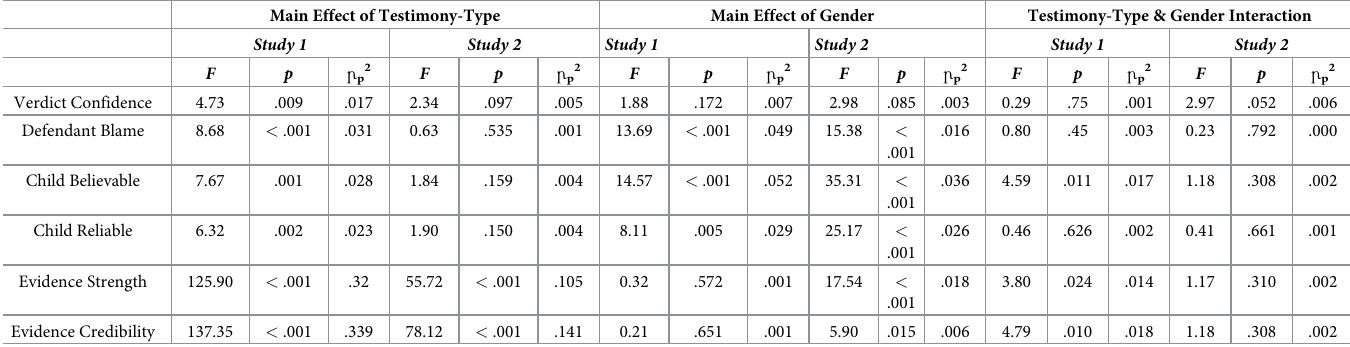
Table 2. ANOVA results for all main Dependent Variables in Study